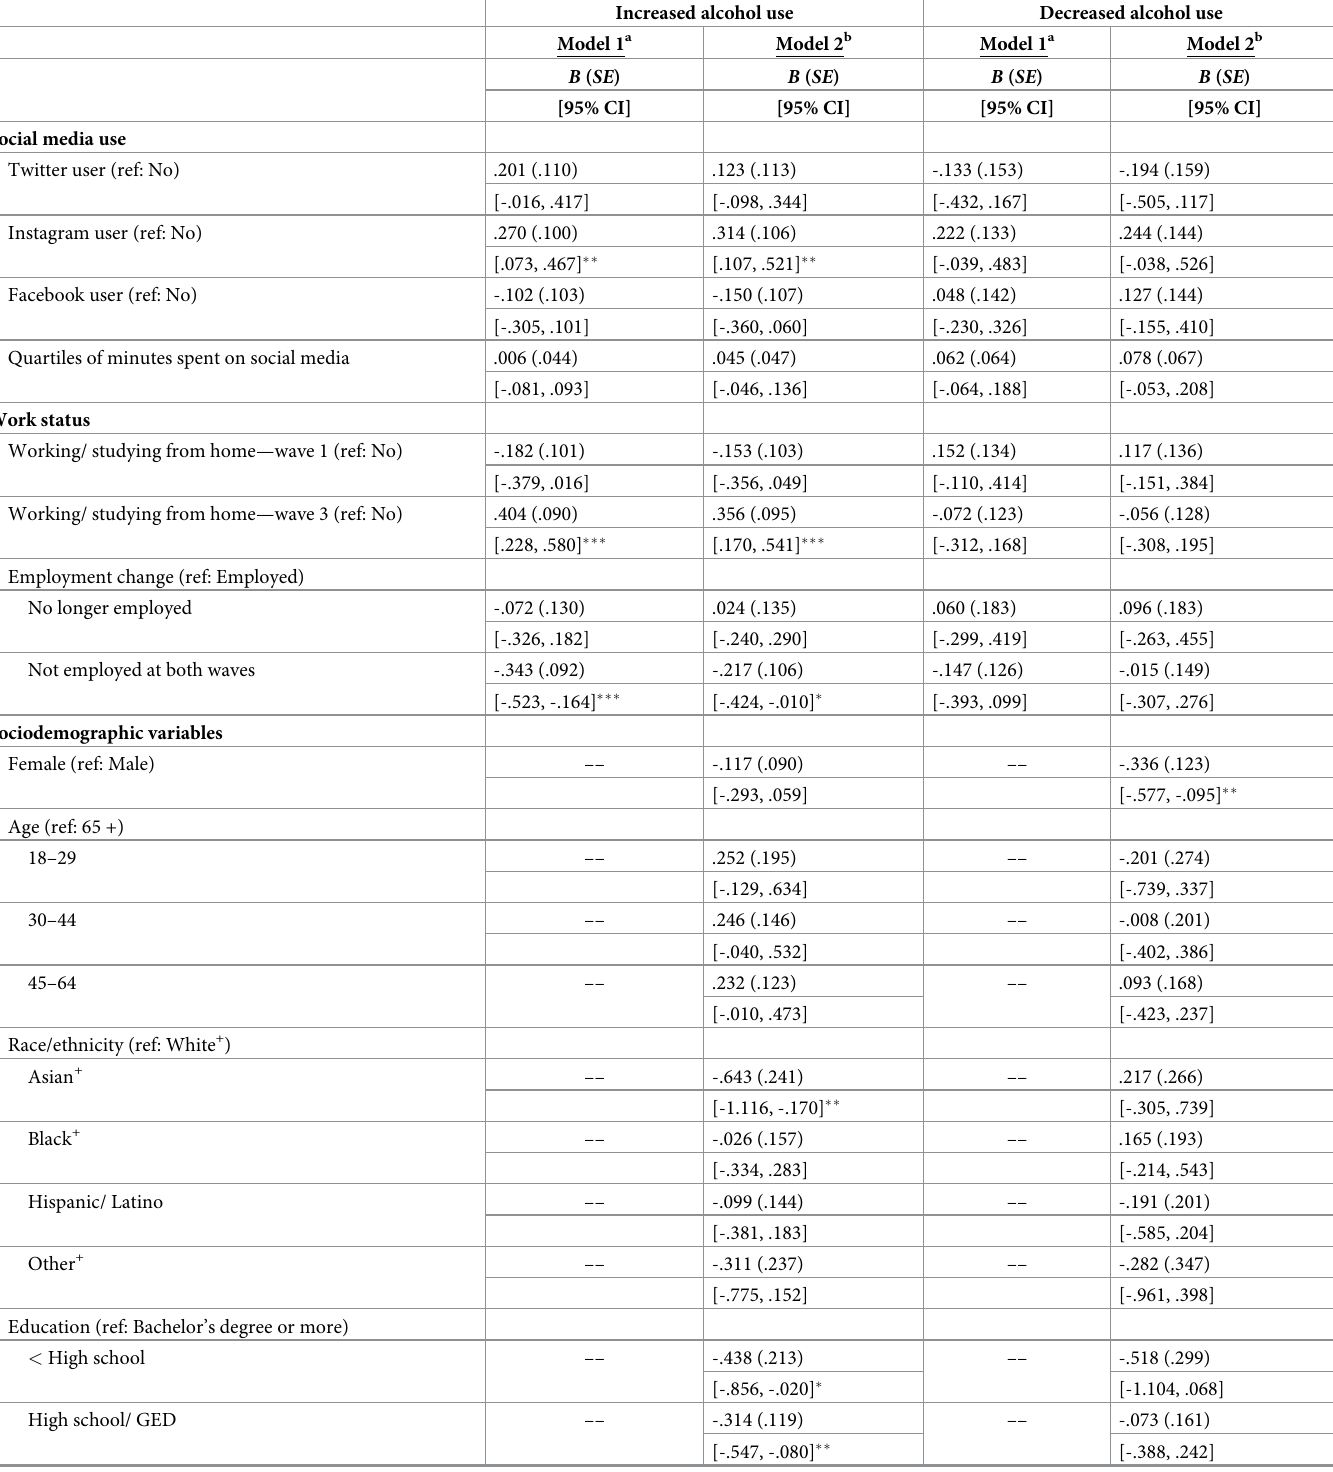
Table 4. Hierarchical logistic regression models for alcohol use change